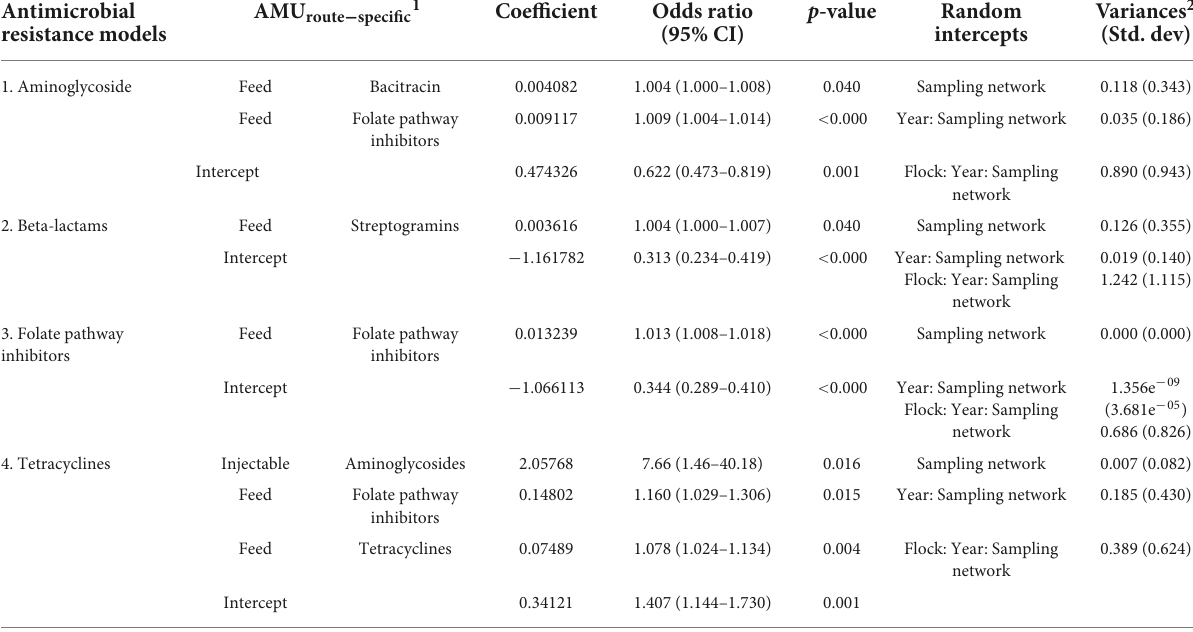
TABLE 3a Multivariable mixed-effects logistic regression models showing associations between antimicrobial use via specific administration routes in turkey flocks ( n = 334) and homologous and multidrug-resistant E. coli isolates ( n = 1,317), 2016–2019. Antimicrobial resistance models